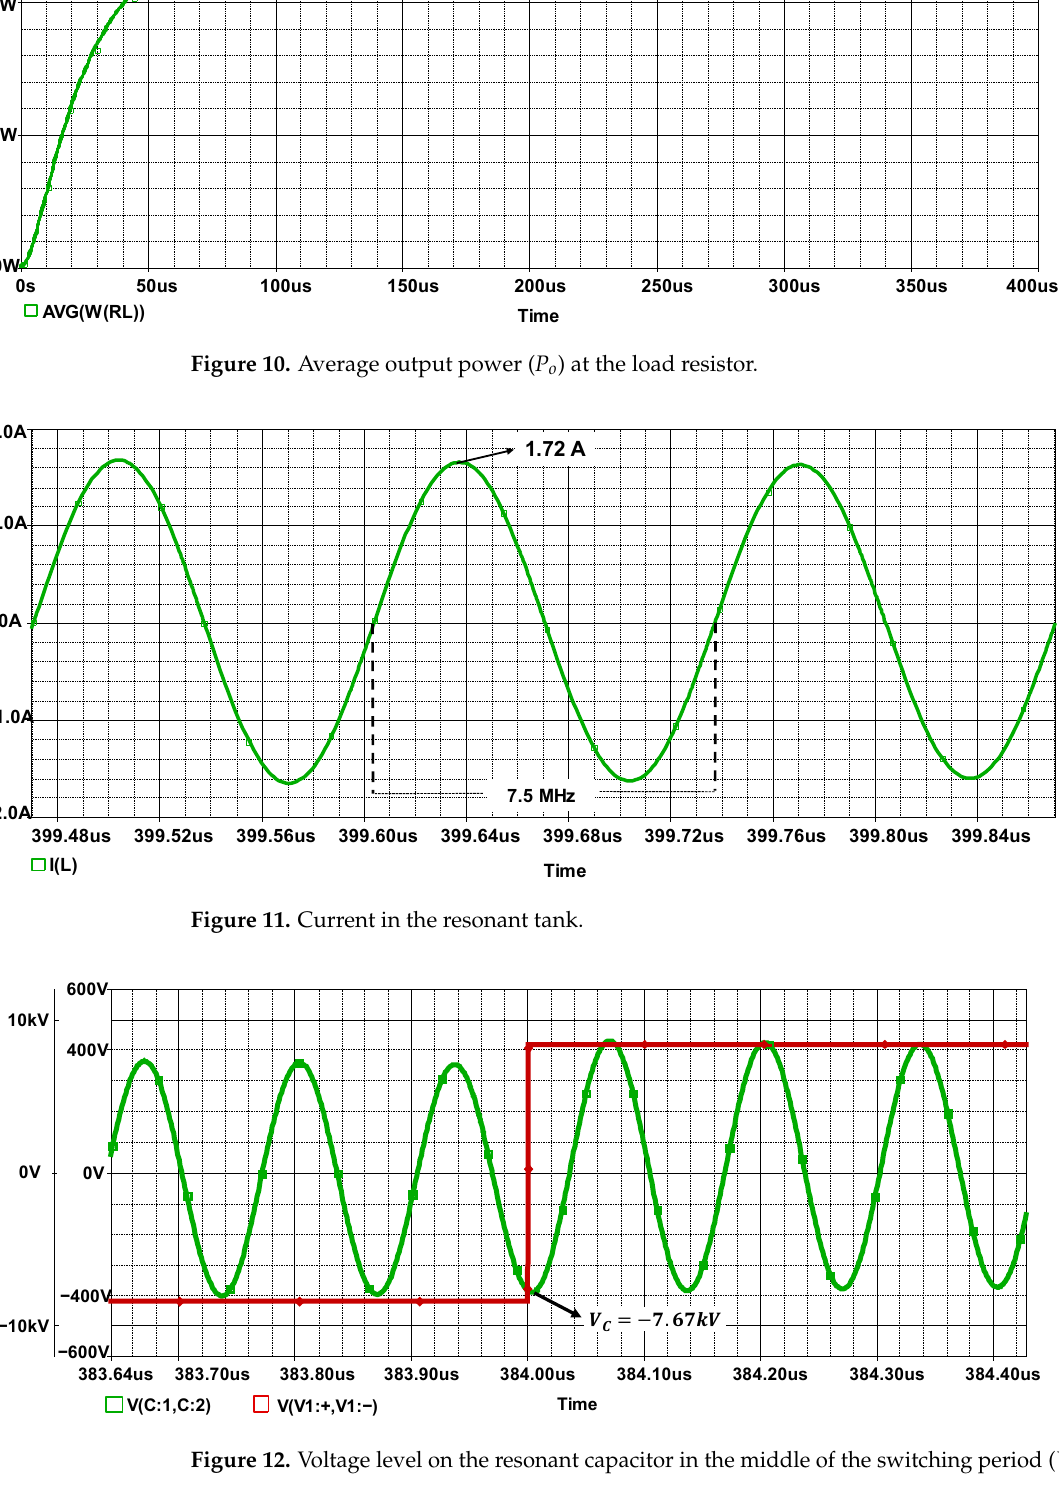
Figure 13. Current in the resonant tank (sinusoidal waveform) with “ n ” complete cycles in one cycle of the bipolar voltage source (square waveform). ( a )